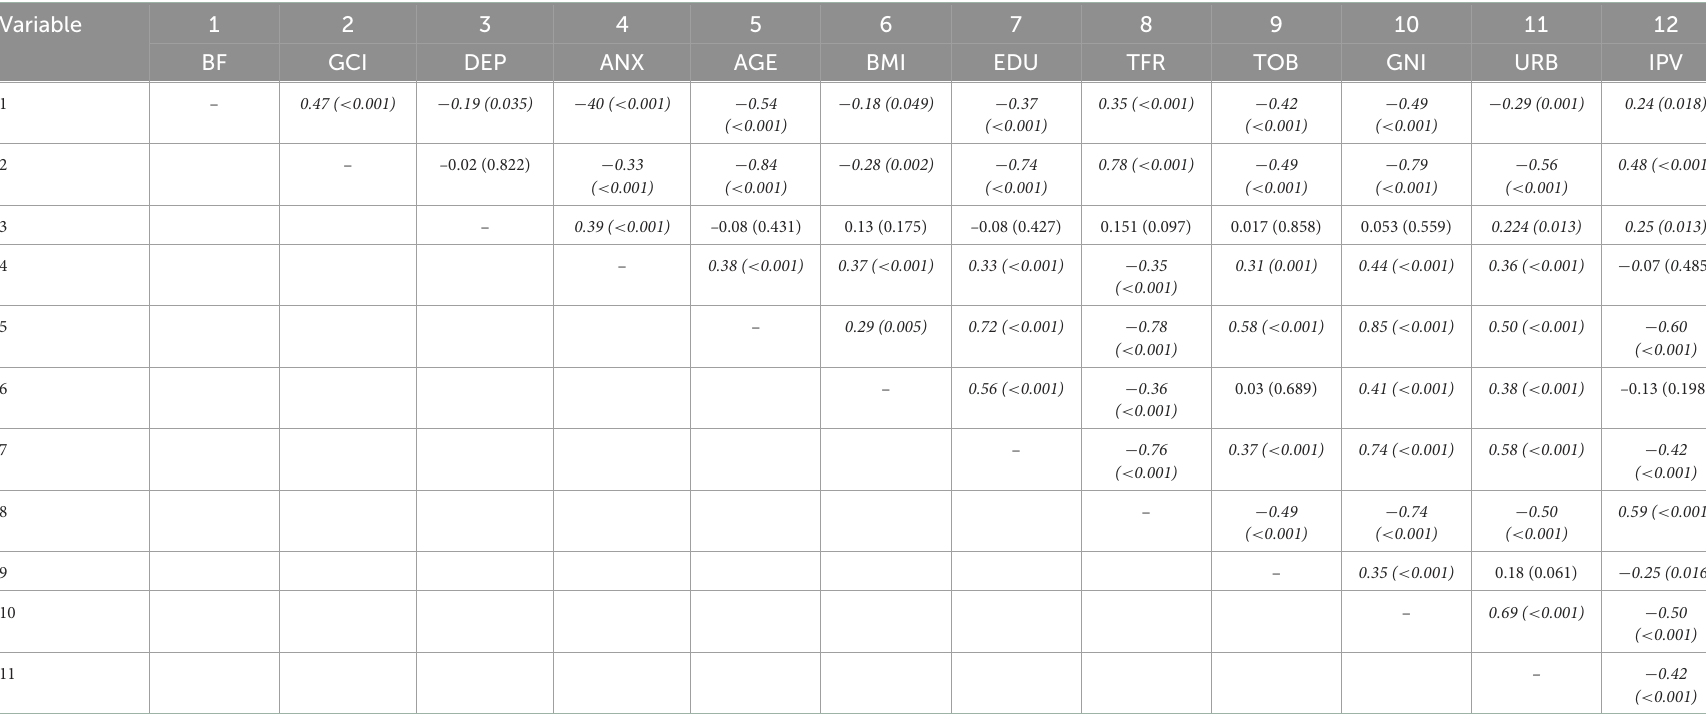
TABLE 4 Confirmatory correlations between national lifetime breastfeeding rates, individualism-collectivism, the prevalence of anxiety and depression in women aged 15–49, and confounding factors. Variable